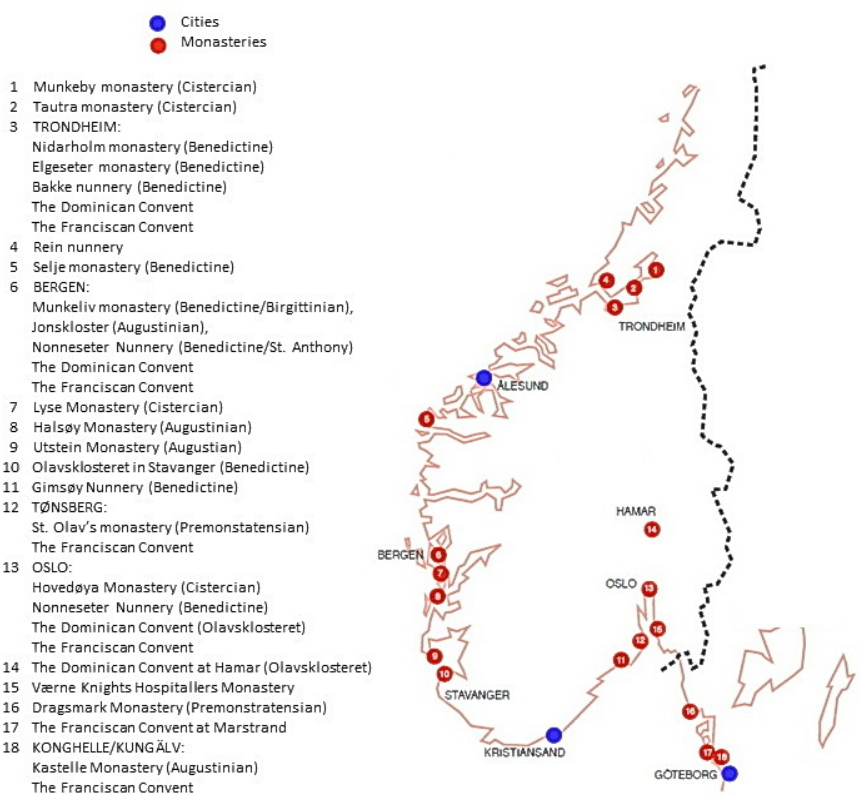
Figure 2. Medieval Norwegian monasteries, nunneries and convents.